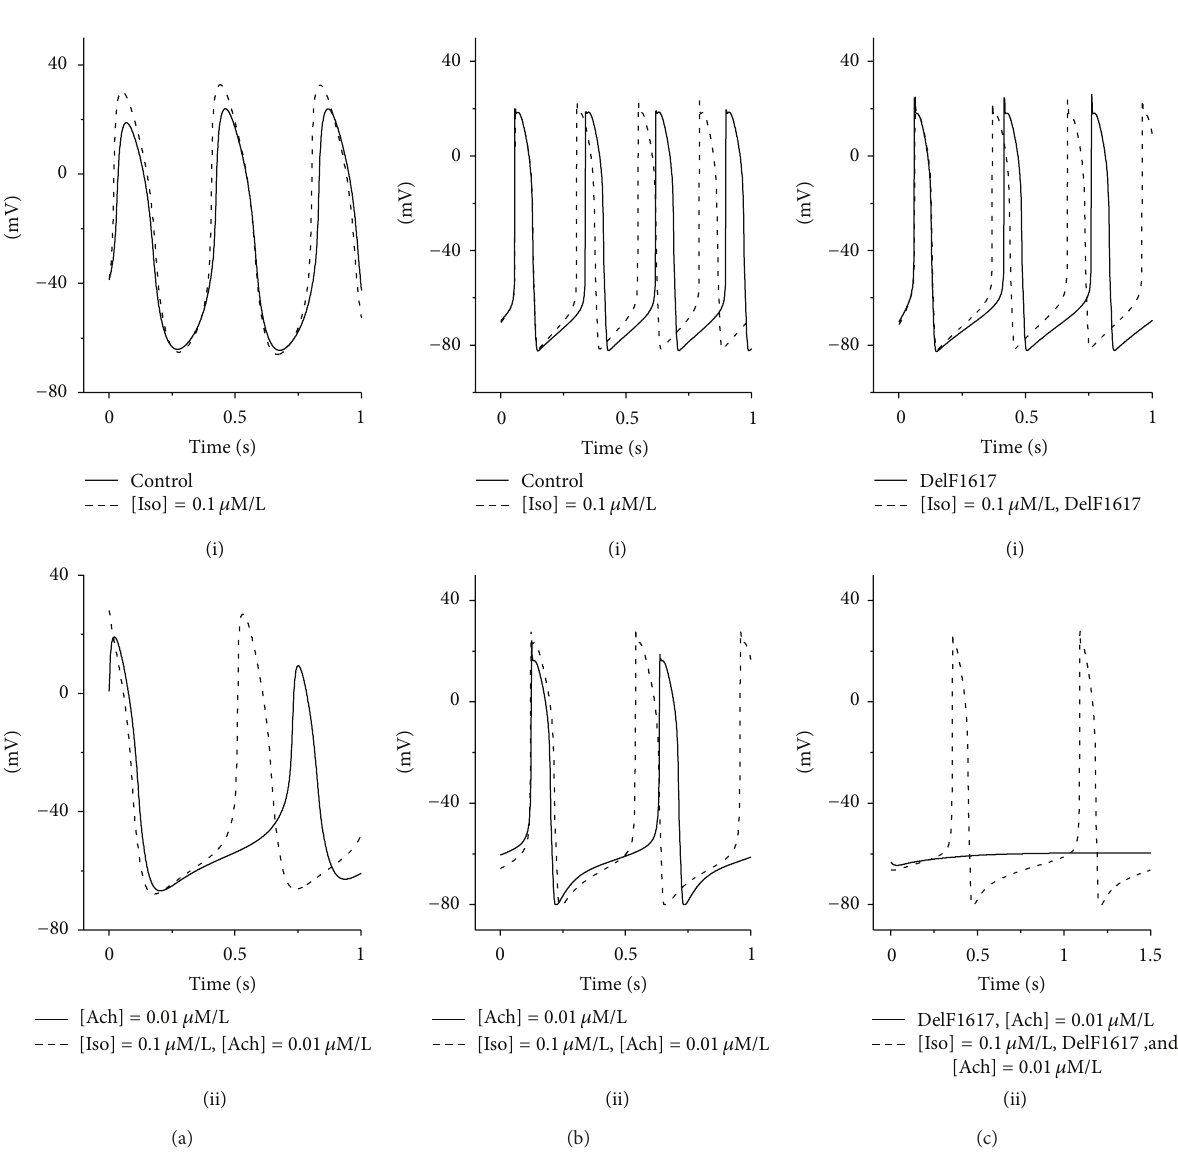
Figure 3: Effect of Iso on the SAN pacemaking rate. Simulated voltage from (a) central cell models and ((b) and (c)) peripheral cell models. Action potentials are shown under control conditions and in the presence 0.1 𝜇 M/L Iso, 0.01 𝜇 M/L Ach, and the DelF1617 mutant